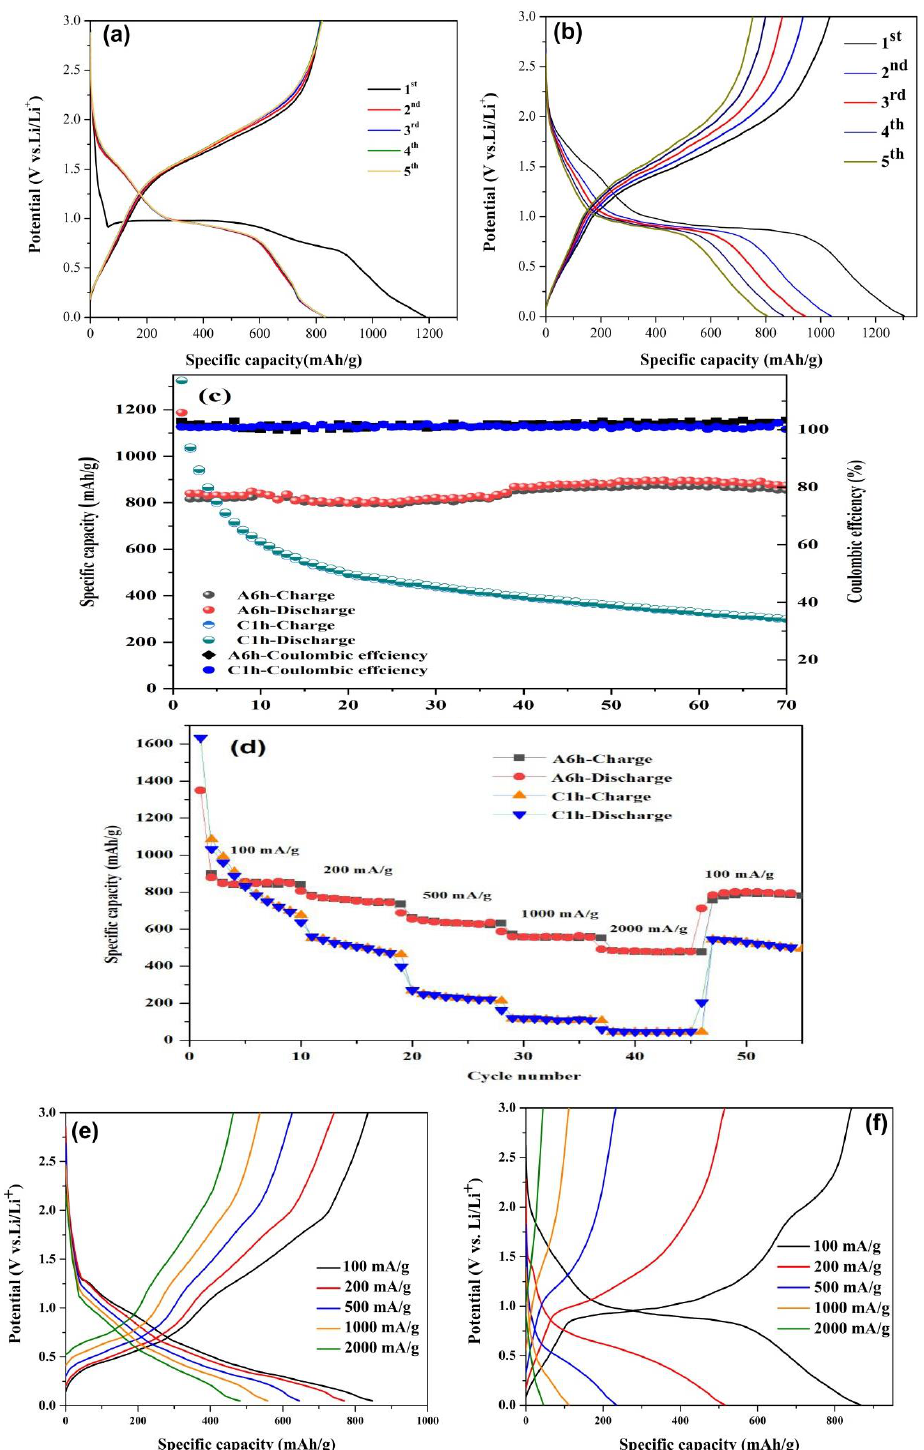
Figure 6. Discharge–charge voltage profiles of the amorphous and crystalline Fe 2 O 3 electrodes for the initial five cycles at a rate of 100 mA/g between 0.005 and 3.0 V: ( a ) A6h and ( b ) C1h. ( c ) Cycle performances of the A6h and C1h electrodes and their corresponding Coulombic efficiencies. ( d ) Rate performances of the A6h and C1h electrodes at different current rates. The fourth cycle charge/discharge profiles of amorphous and crystalline Fe 2 O 3 electrodes at different current densities: ( e ) A6h and ( f )